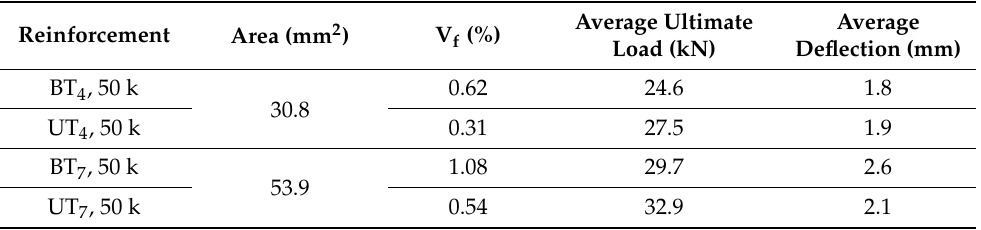
Table 6. The effects of numbers of woven textiles on the load and deflection of uni- and bi-axial TRC beam samples.